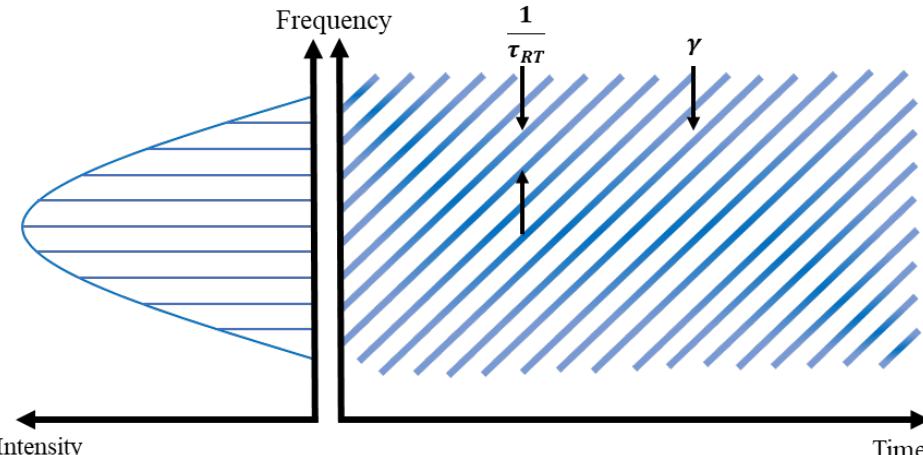
Figure 1. Schematic of a comb of chirped frequencies.